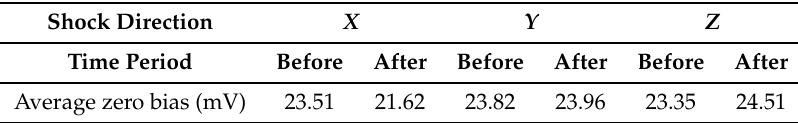
Table 6. Simulation results of the transient dynamic analysis along the x -, y - and z -axis. Shock Direction X Y Z Time Period Before After Before After Before After Average zero bias (mV) 23.51 21.62 23.82 23.96 23.35